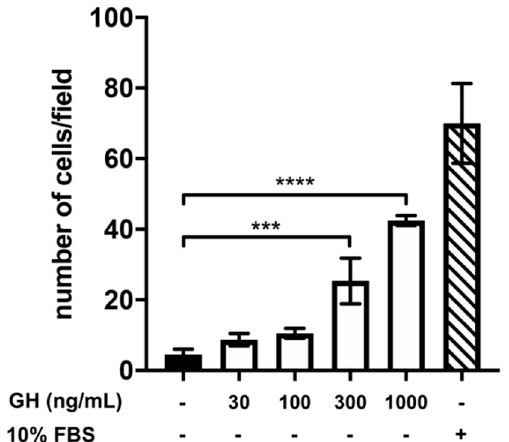
Figure 3. Effect of different concentrations of growth hormone (GH) on GN11 cell migration. Data are expressed as mean ± SD, n = 8. One experiment representative of three separate experiments is shown. *** p < 0.001; **** p < 0.0001 (One-way ANOVA followed by the Dunnett post-hoc test).